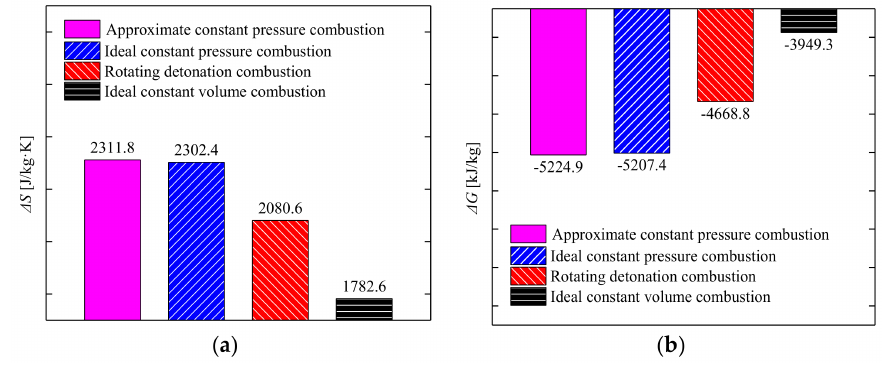
Figure 7. ( a ) ∆ S and ( b ) ∆ G using different